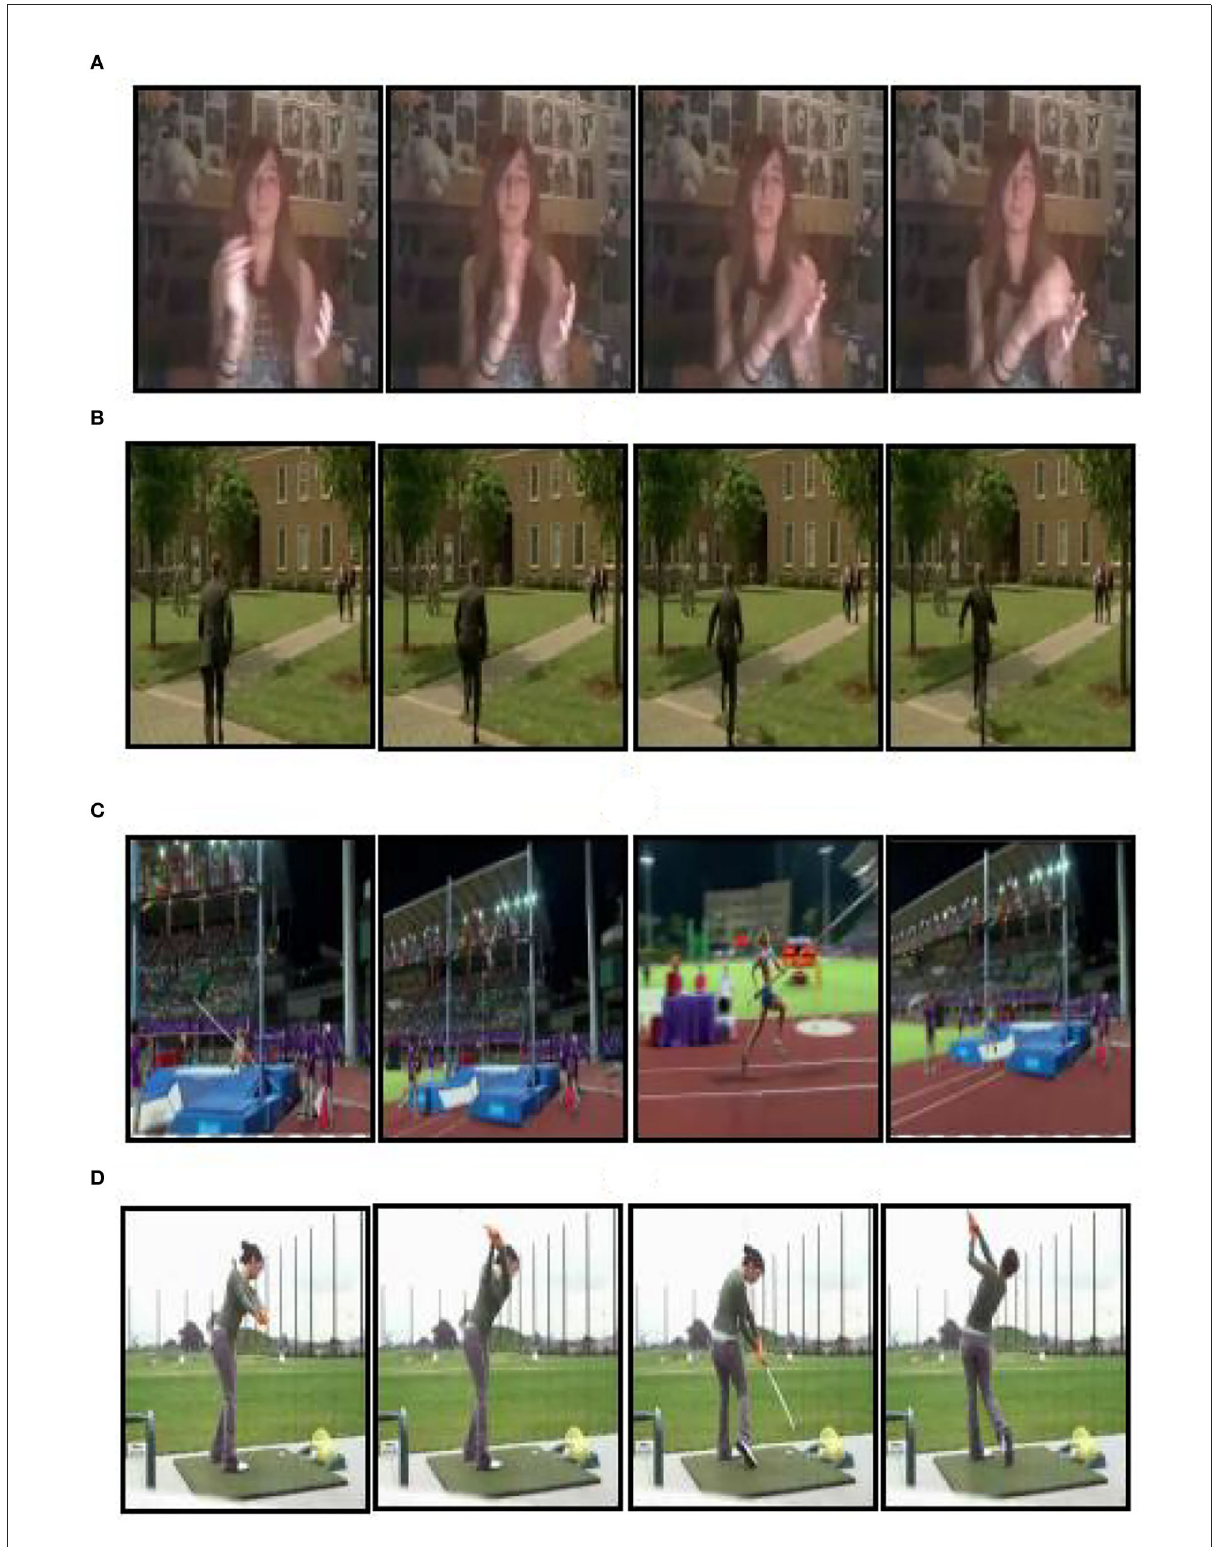
FIGURE1 (A–D) The motivation of